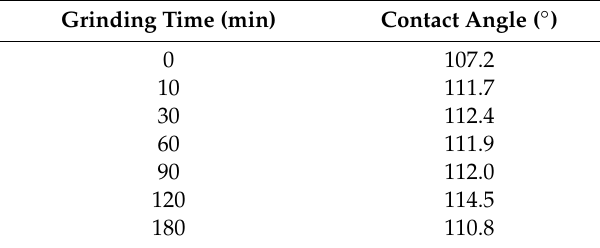
Table 1. Contact angle under di ff erent ball grinding